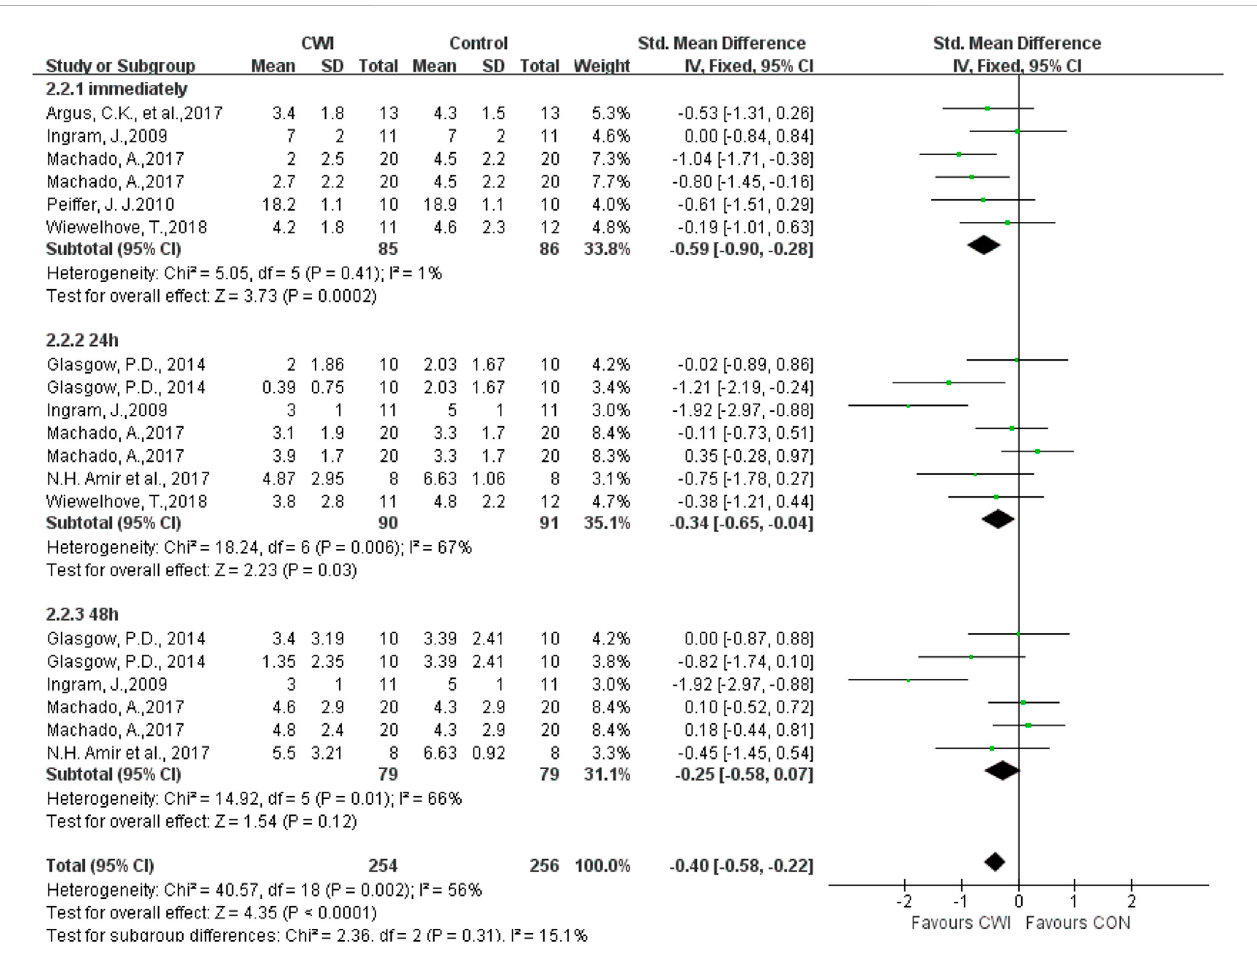
FIGURE 5 Forest plot of the comparison of CWI versus CON for measurement of DOMS. CWI = Cold water immersion, CON = Control, DOMS = delayed-onset muscle soreness.